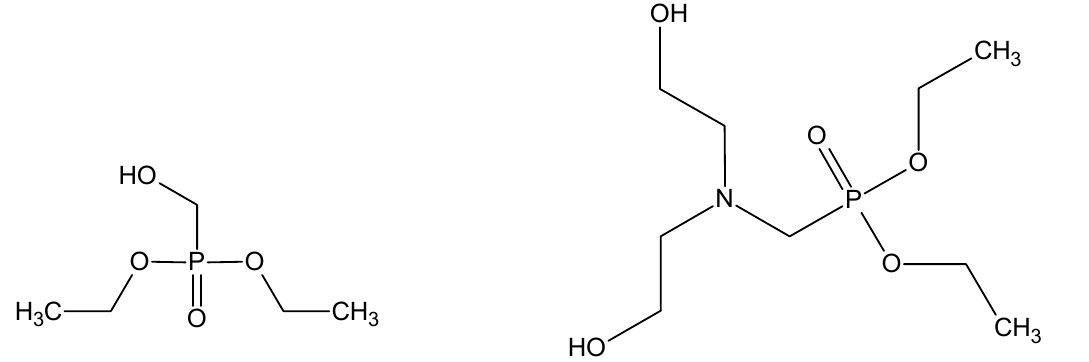
Figure 10. Chemical structure of the reactive flame retardants RM and RE.